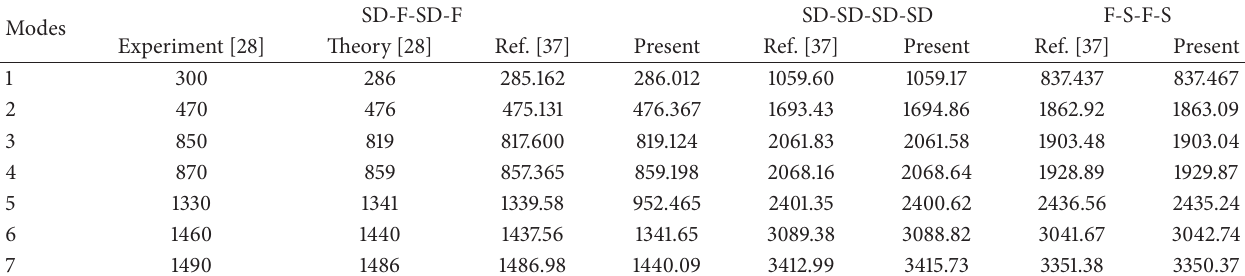
Table 3: Comparison of the first seven natural frequencies (Hz) for an open cylindrical shell with various boundary